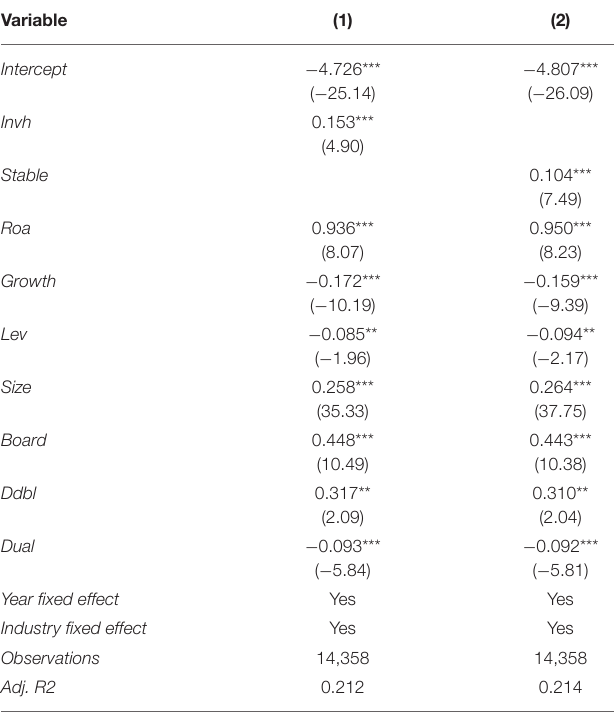
TABLE 5 | Institutional investors’ heterogeneity and environmental information disclosure quality.